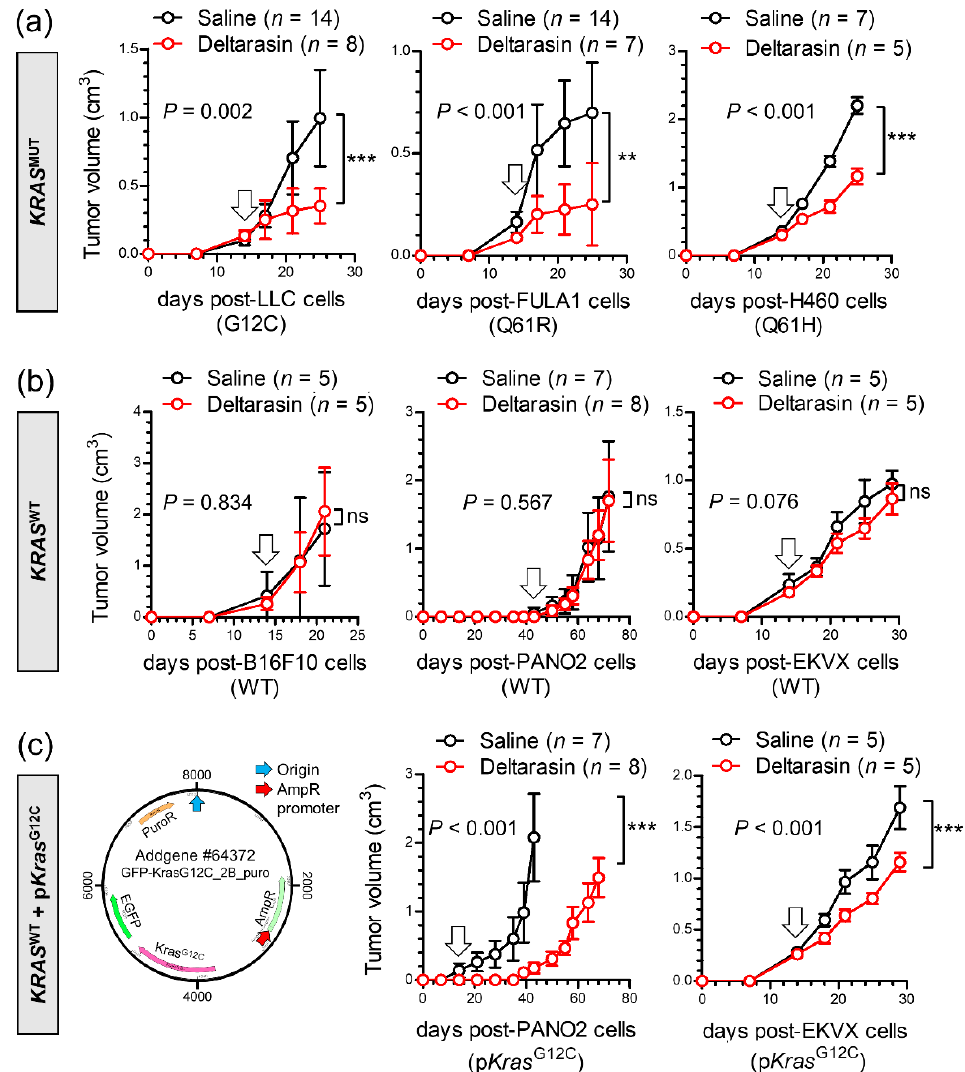
Figure 2. Deltarasin-mediated demonstration of KRAS mutation-dependence in vivo. Different mouse and human tumor cell lines with (( a ); KRAS MUT ) and without (( b ); KRAS WT ) endogenous Kras/KRAS mutations (codon changes are given in parentheses), as well as KRAS WT cell lines forcedly expressing a plasmid encoding mutant murine Kras G12C (( c ); p Kras G12C ), were injected into the rear flank (10 6 tumor cells sc) of C57BL/6 (LLC, B16F10, and PANO2 cells), FVB (FULA1 cells), or Rag2 −/− (H460 and EKVX cells) mice. After tumor establishment (tumor volume > 100 mm 3 ; arrows), mice were randomly allocated to daily ip treatments with 100 μL saline (black) or 15 mg/ Kg deltarasin in 100 μL saline (red). Tumor growth was assessed by measuring three vertical tumor dimensions. Data presented as mean ± SD. n , sample size; p , overall probability, two-way ANOVA; ns, **, and ***: p > 0.05, p < 0.01, and p < 0.001, respectively, Bonferroni post-test. Rag2, recombination activating gene 2; sc, subcutaneously; ip, intraperitoneal.